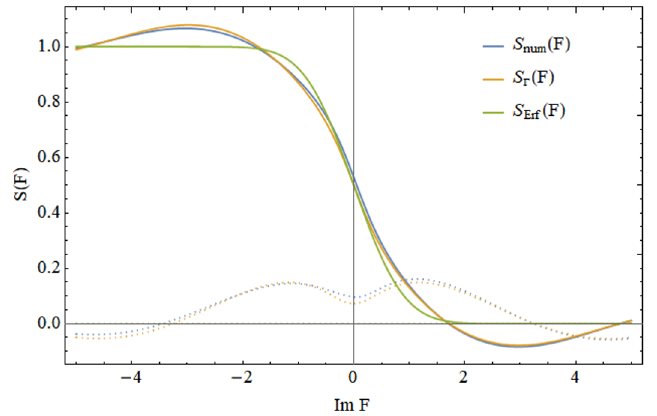
Figure 5 . The comparison between S num ( F ) , S Γ ( F ) and S Erf ( F ) , where all of them are normalized such that the final value approaches 1 and Re F = 0 . 5 . The solid lines represent the real parts, whereas the dashed lines are the imaginary